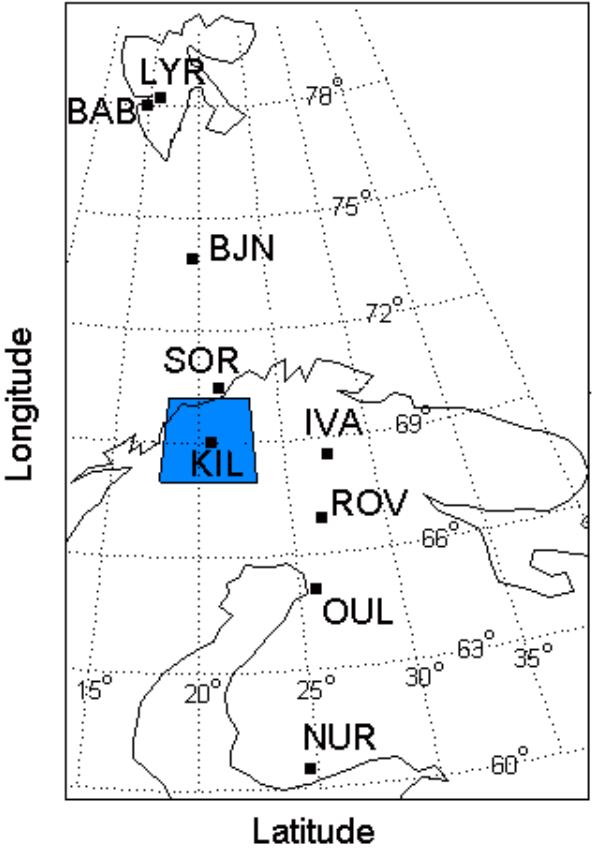
Fig. 1. Location of the instruments in the region of observations. Blue area is field of view of the imaging riometer IRIS